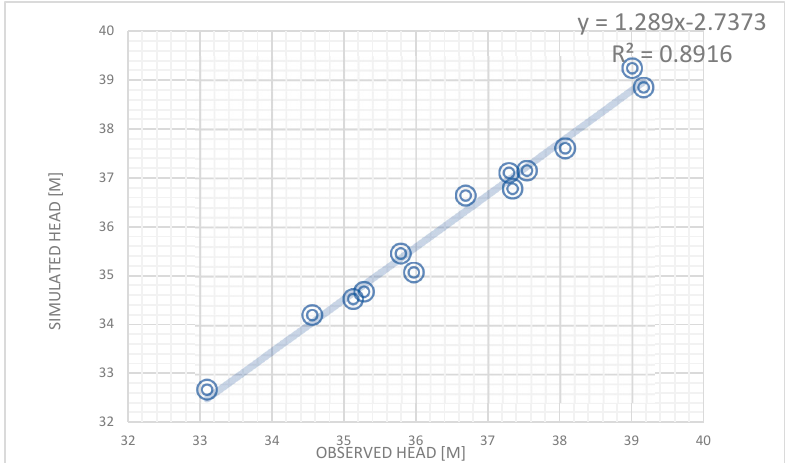
Figure 5. Correlation between simulated and observed head value.